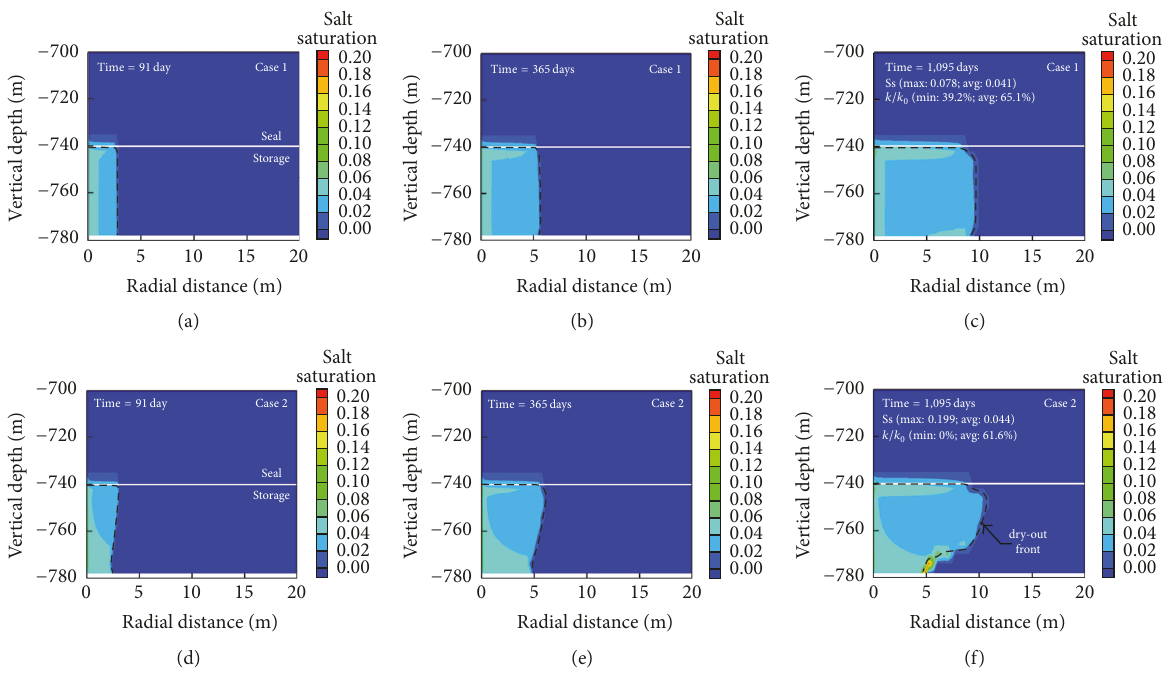
Figure 6: Distribution of salt saturation [-] shown as color contours and the dry-out front as dashed lines at a series of times (91, 365, and 1,095 days). (a), (b), and (c) were simulated from the EPM model (Case 1 ), but (d), (e), and (f) were from the WR model (Case 2 ).